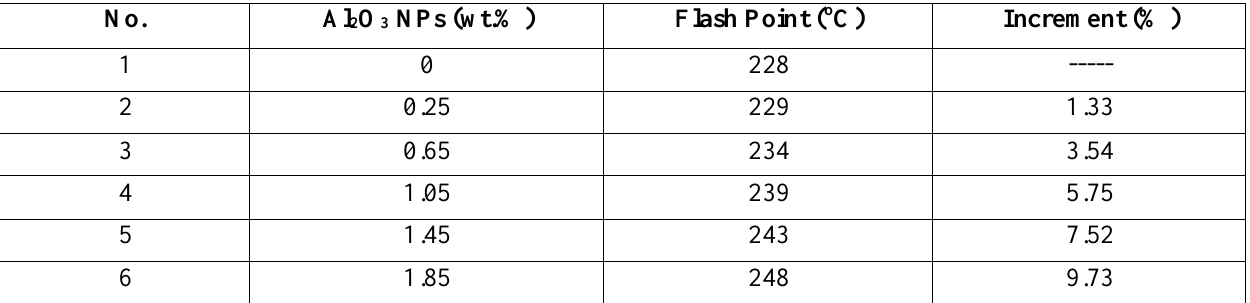
Table 4: Variation of flash point at various Al 2 O 3 NPs